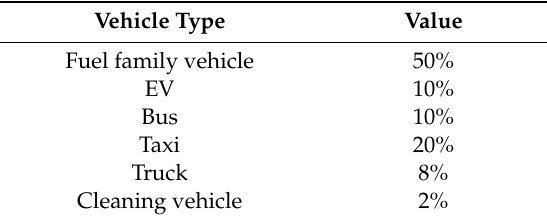
Table 4. The proportion of each vehicle type in the tra ffi c simulation